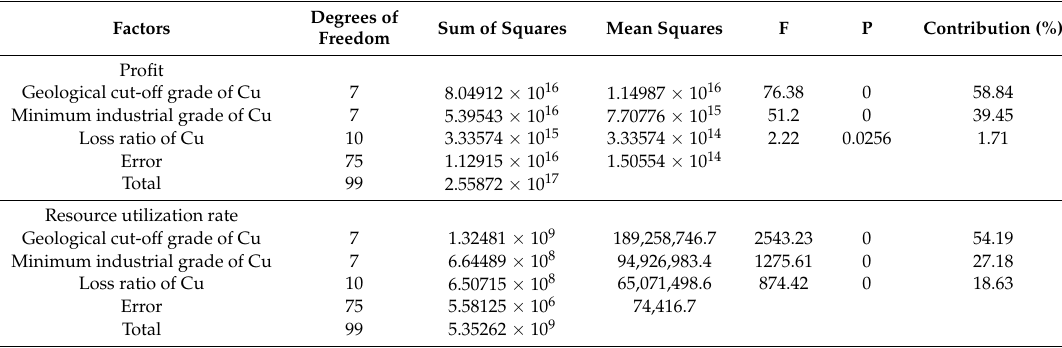
Table 5. Variance analysis for profit and resource utilization rate.